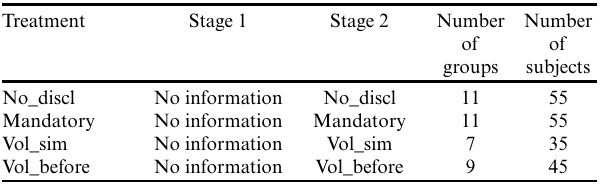
Table 1 . Overview of treatments.